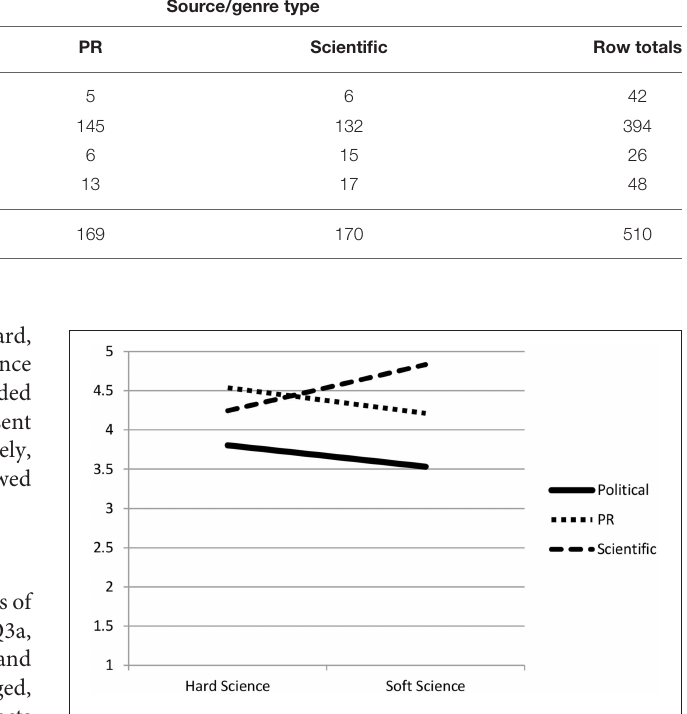
TABLE 2 | Detailed contingency table: coded response to comprehension question. Coded response